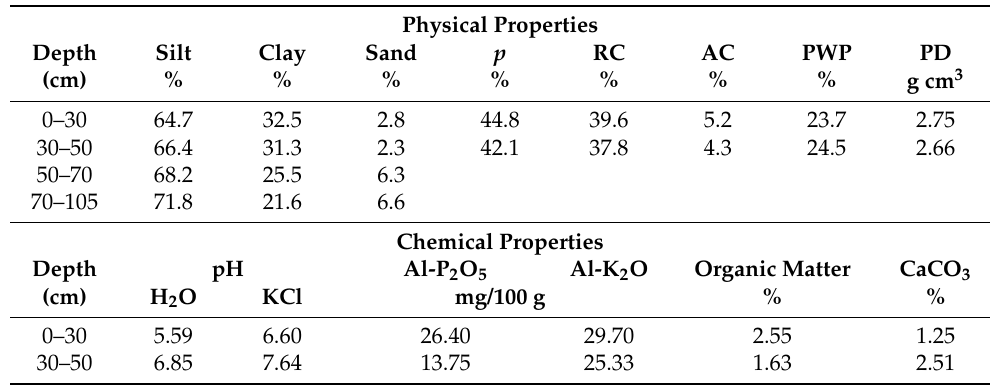
Table 1. Physical and chemical properties of the soil.